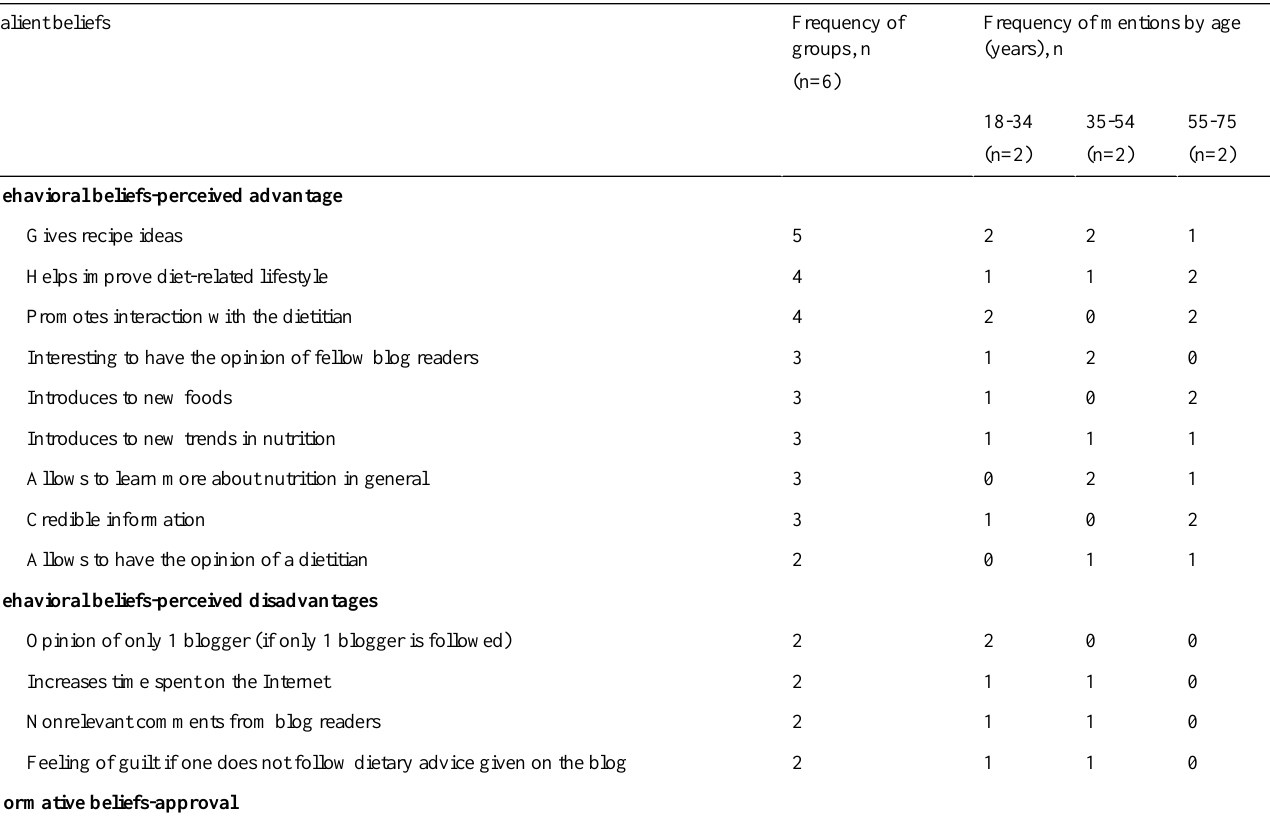
Frequency of mentions by age nFrequency of (years), groups, n